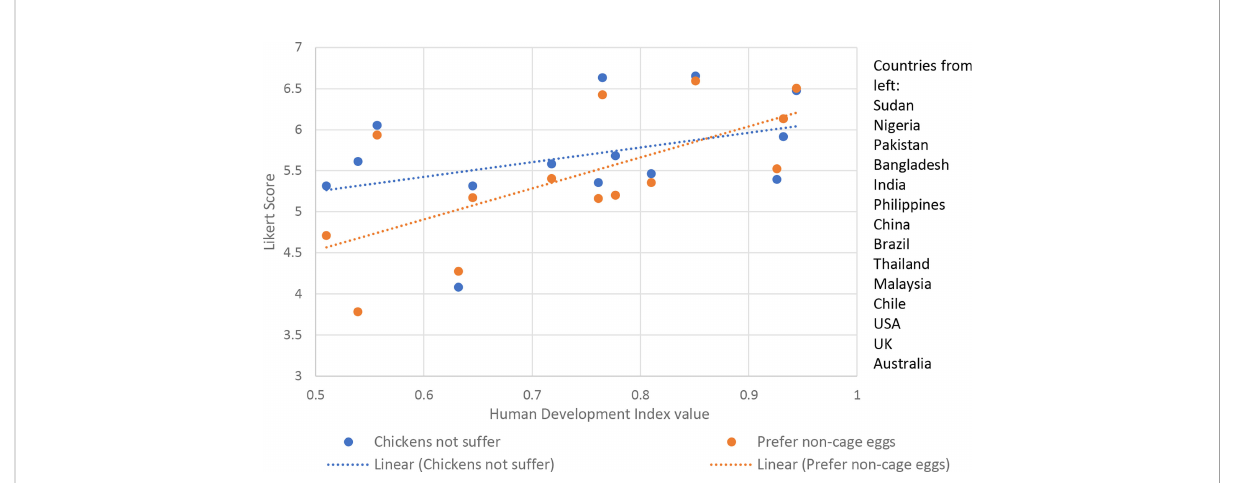
FIGURE 6 Scatter Plot modelling Human Development Index value against Likert scores for “ It matters to me that the chickens producing eggs do not suffer ” (R 2 = 0.156, ns) and “ I would prefer to buy eggs from chickens that have not been kept in cages ” (R 2 = 0.444,